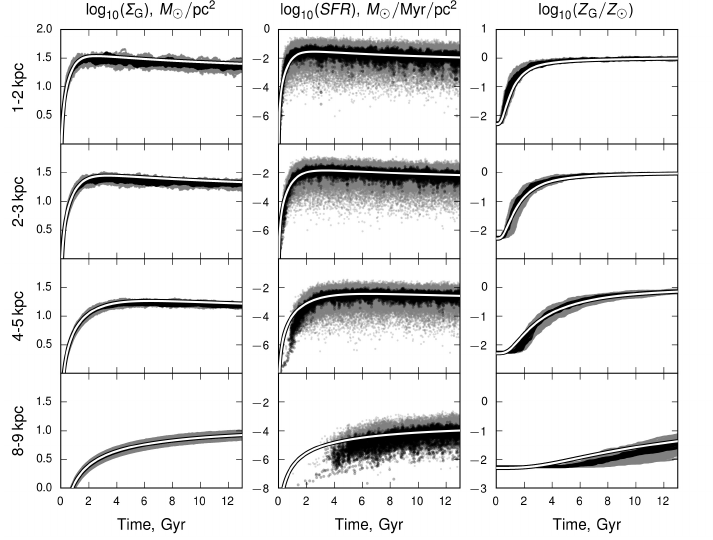
Fig. 4. The same as in Fig. 3, but for the HS